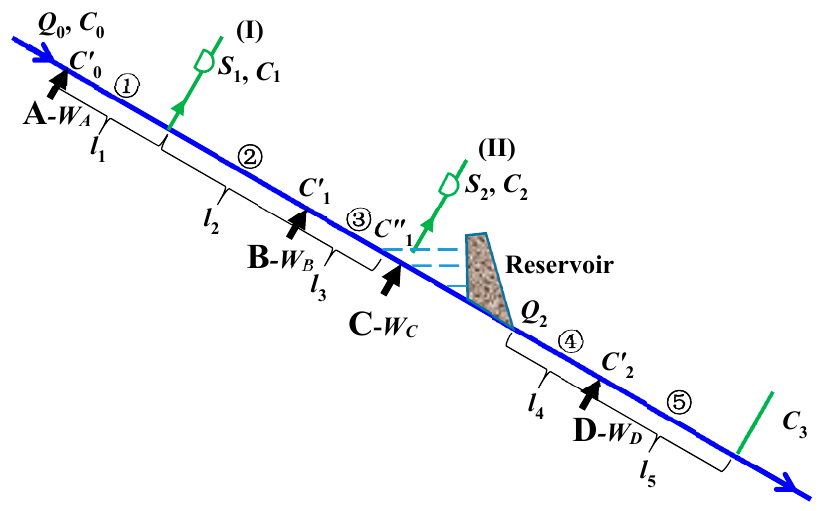
Figure 1. An illustrative example of a river–reservoir system.